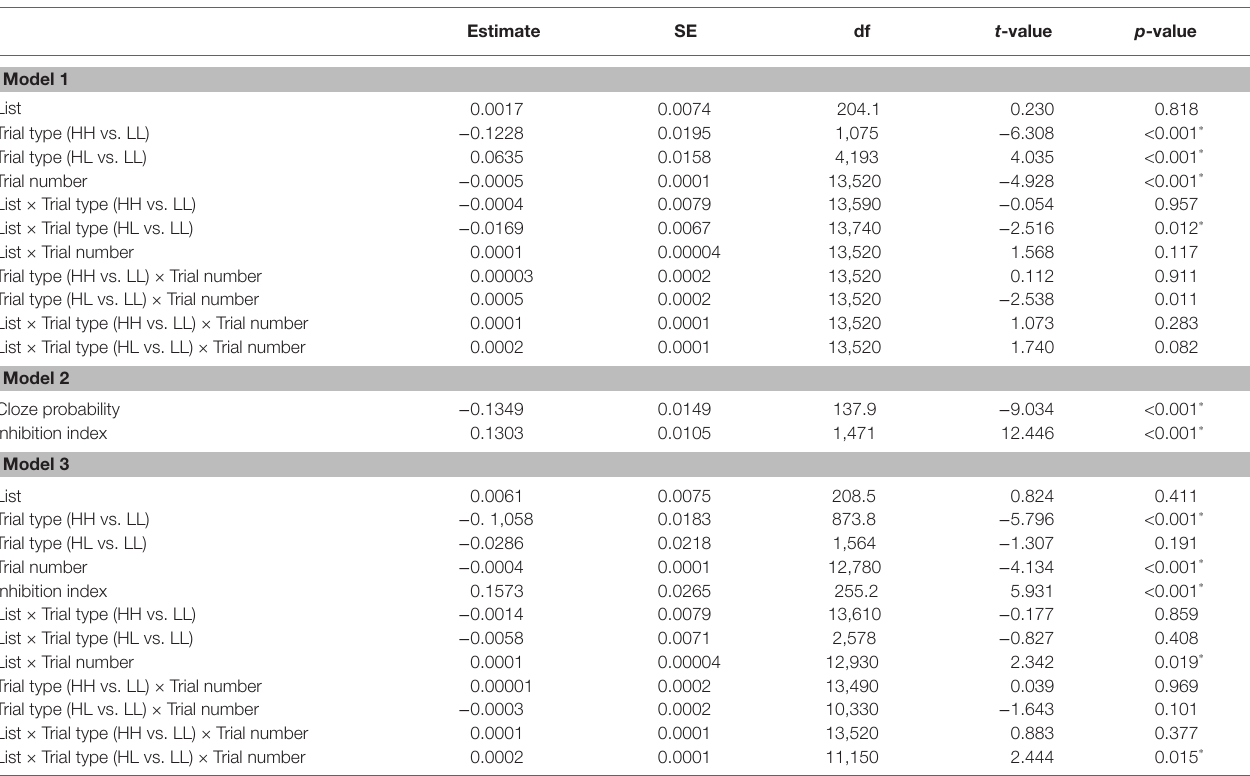
TABLE 5 | Mixed-effects regression models coefficients for Experiment 2.